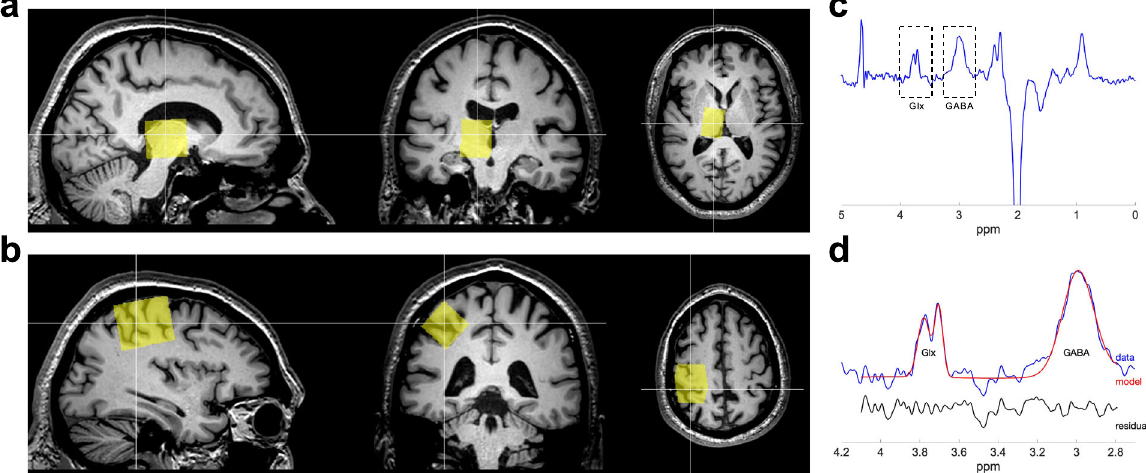
Fig. 1 MRS voxel placement and a representative spectrum. Location of the MRS voxels in a thalamic and b motor cortex areas. c Example of the edited spectrum. d Representative fi tting of the GABA + peak at 3 ppm and the Glx peak at 3.75 ppm in the edited spectrum; acquired data are in blue, fi t in red, and residual in black.